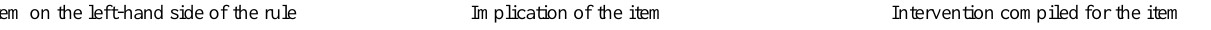
Table 4. Five sample association